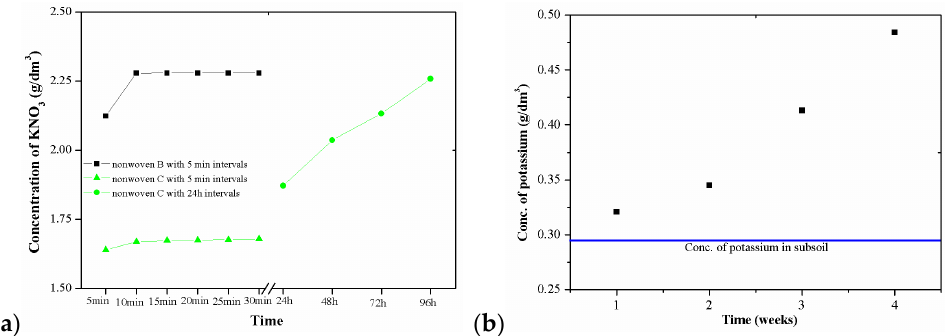
Figure 4. Kinetics of KNO 3 release: ( a ) from nonwovens B and C to water; ( b ) from nonwoven C to the soil.